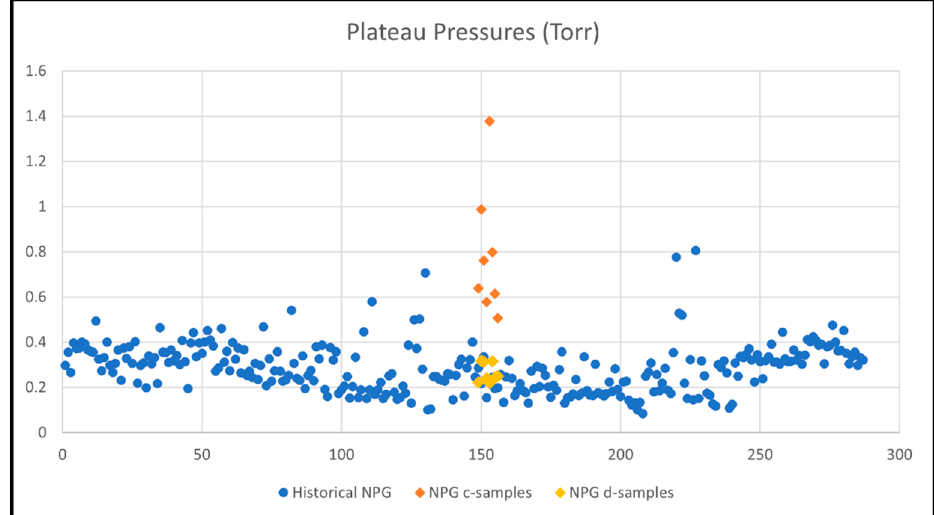
Figure 5. Plateau pressures (y-axis) for historical getter rate tests (280 getters, numbered 1-280 on x-axis) compared with current tests of c-samples (only activated) and d-samples (pretreated and activated). Table 2. Summary of steady state hydrogen plateau pressure and calculated getter absorption rate